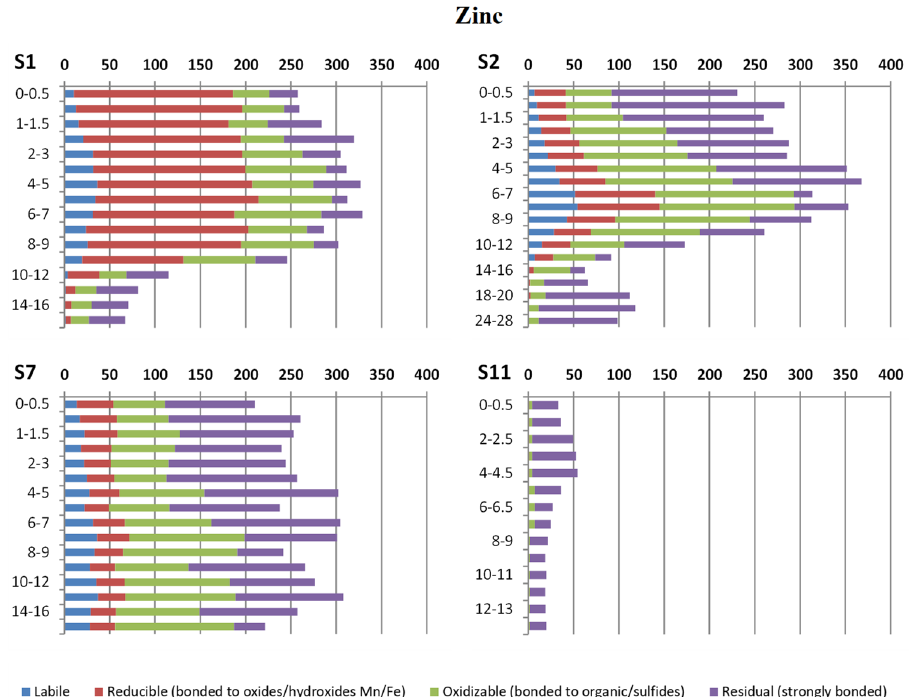
Figure 6. Chemical fractionation of Zn in sediments from the S1, S2, S7, and S11 stations. Horizontal axis: concentration (mg/kg). Vertical axis: core depth (cm).